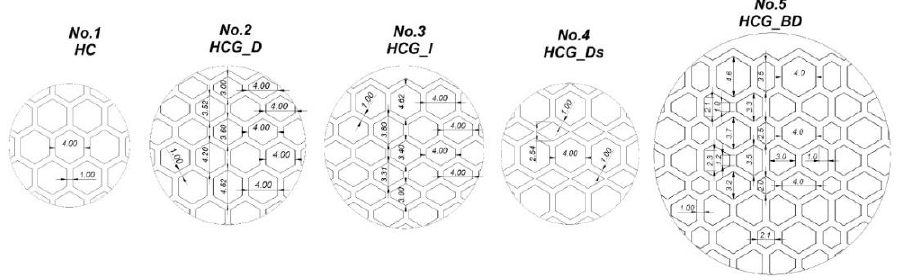
Figure 3. The detailed view of developed structure specimens with different topologies.